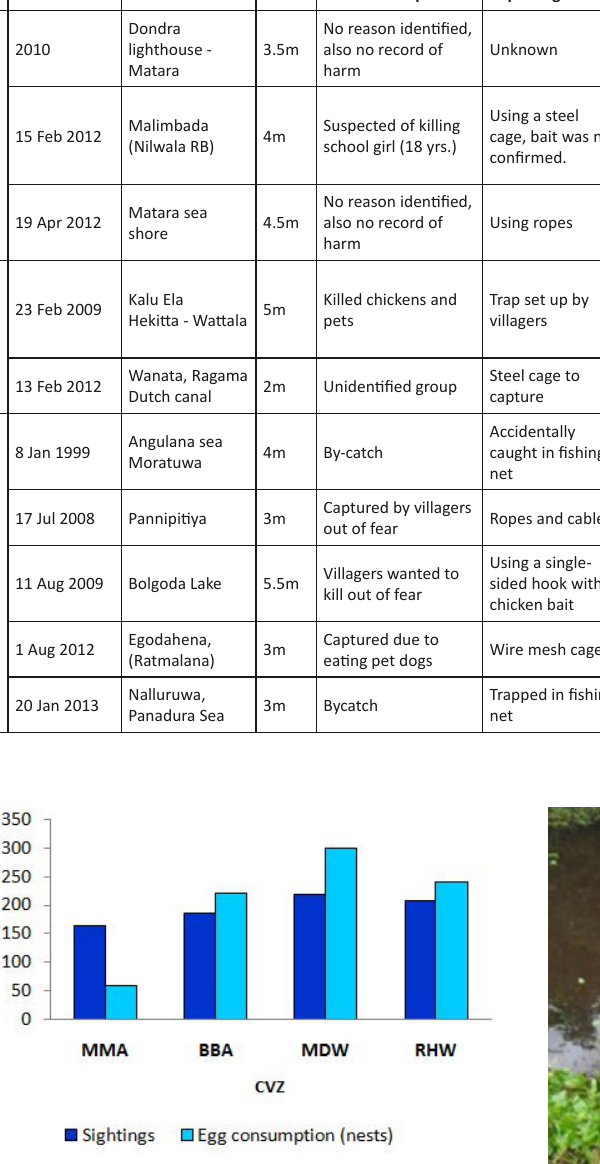
Figure 4. Estimated numbers of Saltwater Crocodile eggs illegally harvested annually for consumption in crocodile vigilance zones,